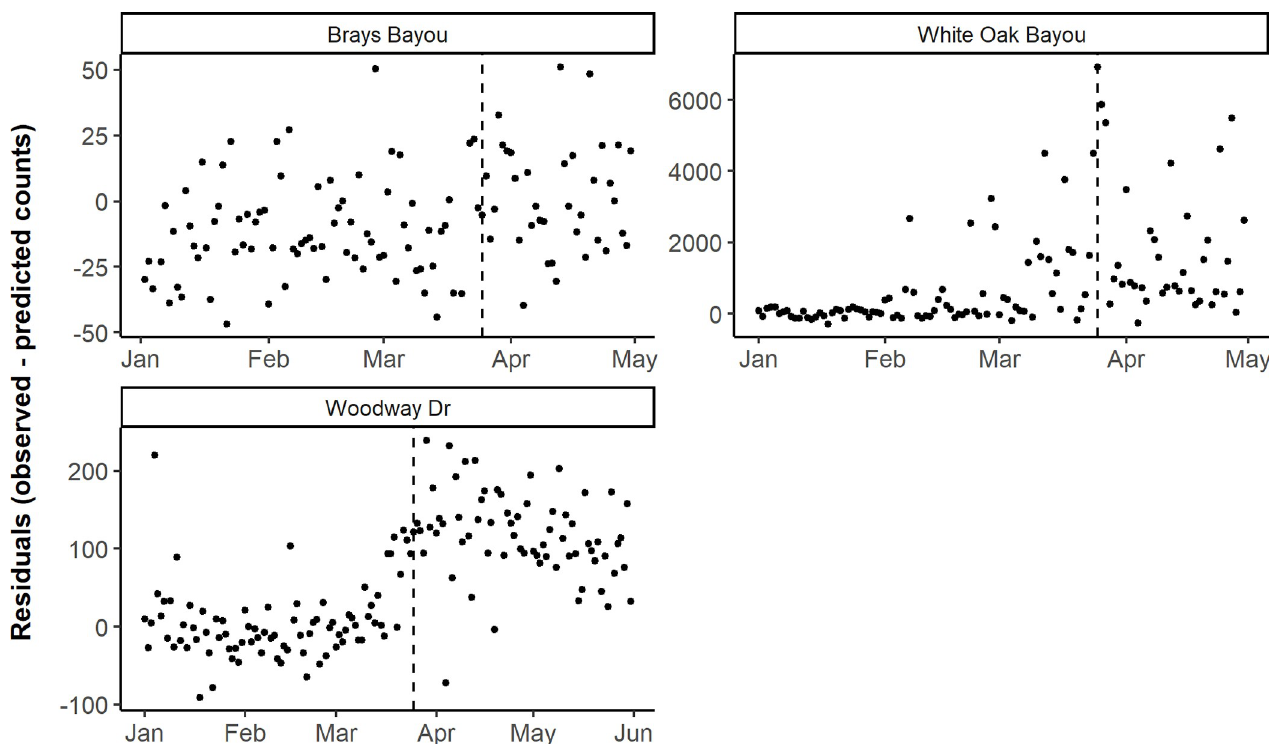
Fig 3. Daily observed minus predicted pedestrian counts by counter location, before and during the Stay Home order in Houston. The vertical dashed line corresponds to the Stay Home order on March 24, 2020 in Harris County, Texas. Note the y-axis scales vary between plots to facilitate the interpretation of